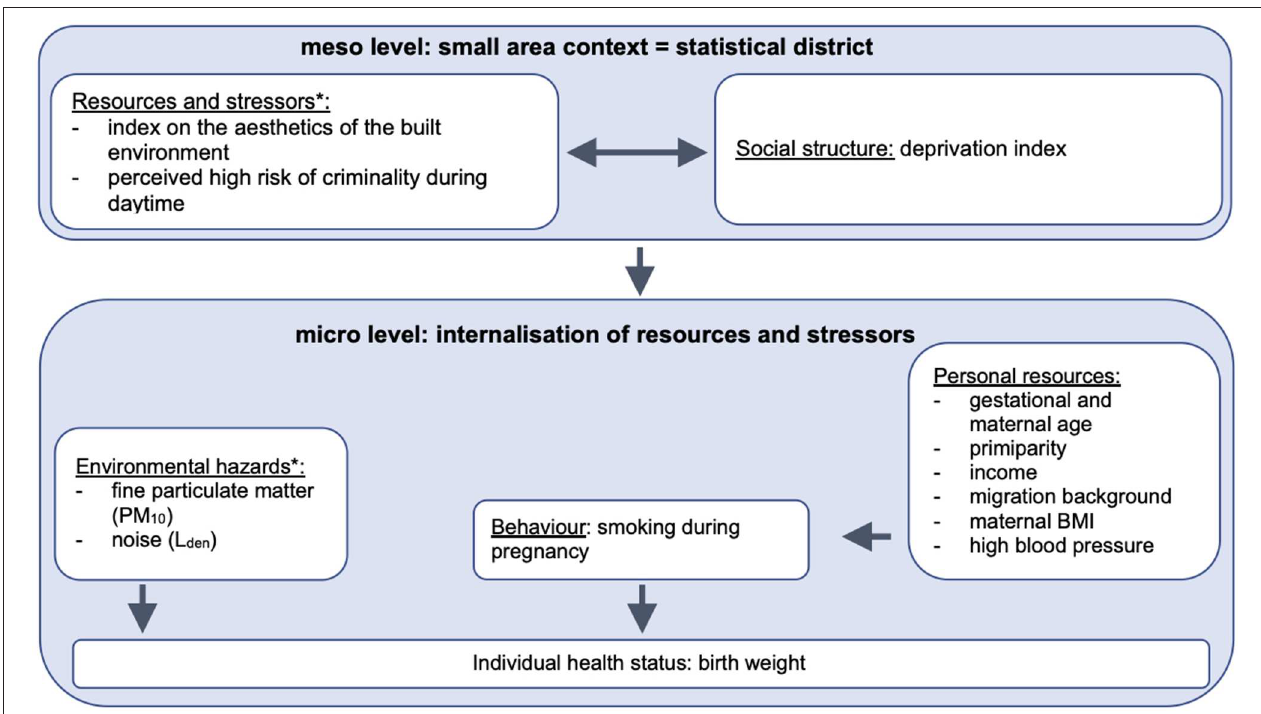
FIGURE 1 | Statistical model on the impact of small-area and individual level characteristics on birth weight. *The variables describe small-area level characteristics but have been measured individually for each participant. The variables have not been aggregated to the statistical districts but are included in their original (individual) form. Author’s own compilation based on Voigtländer et al. (